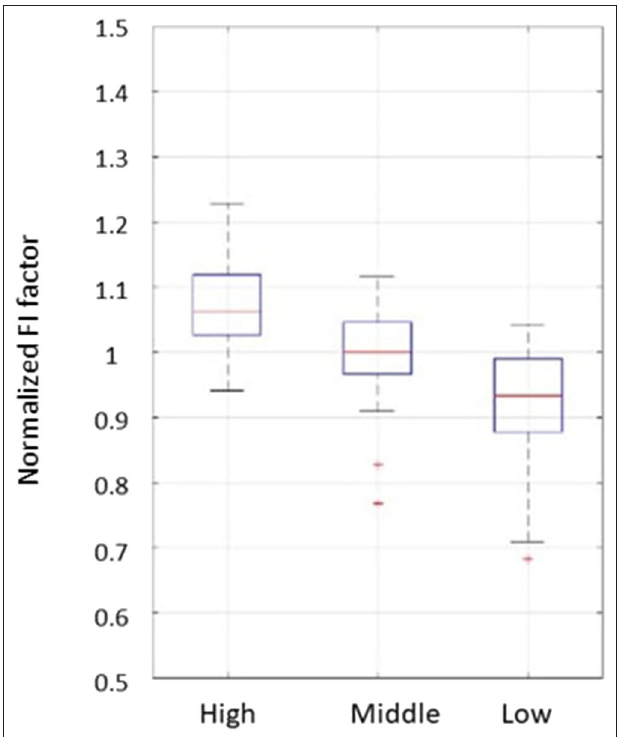
FIGURE 9 | Plots from the fractal index of standard deviation method. Each set of subject data was normalized by its mean value to eliminate fluctuations caused by different transducer positions.